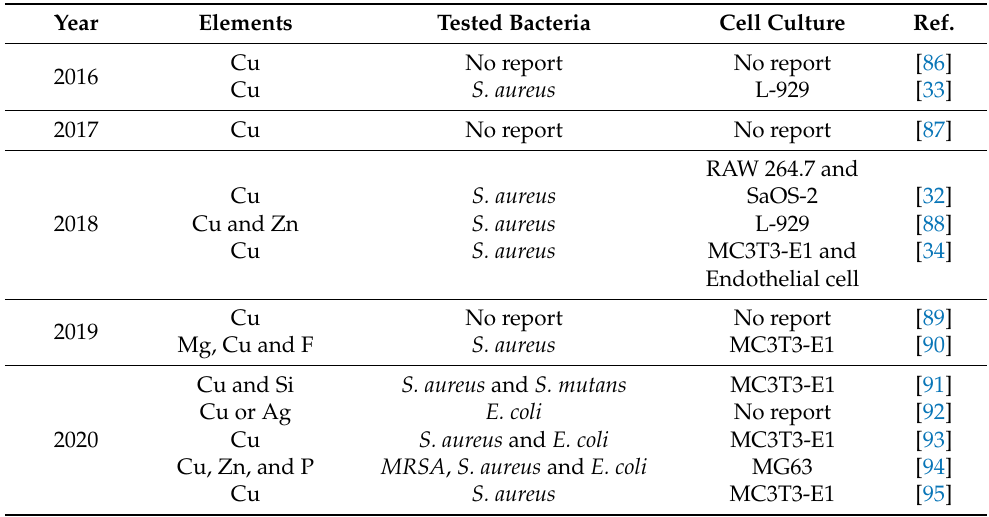
Table 2. Summary of the recent papers related to the incorporation of Cu elements into Ti surfaces by the one-step